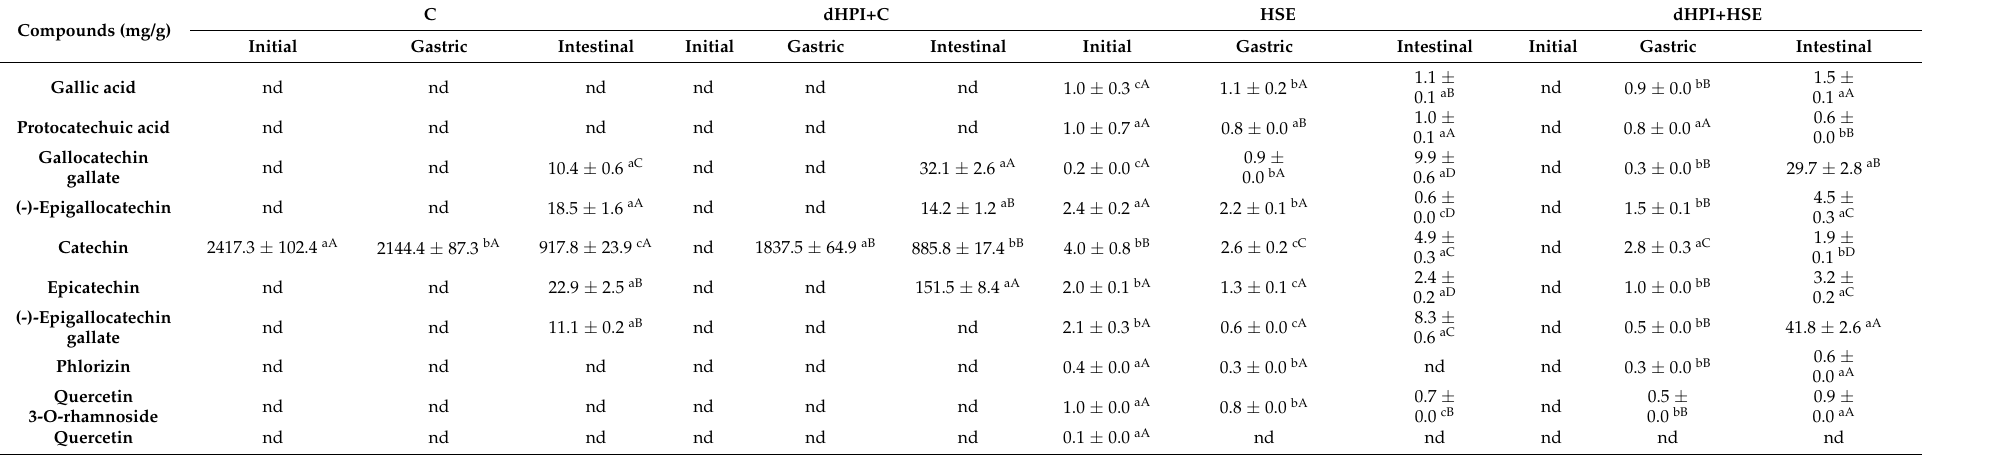
Table 6. Phenolic profiles of initial gastric and intestinal phases of solutions after in vitro GI